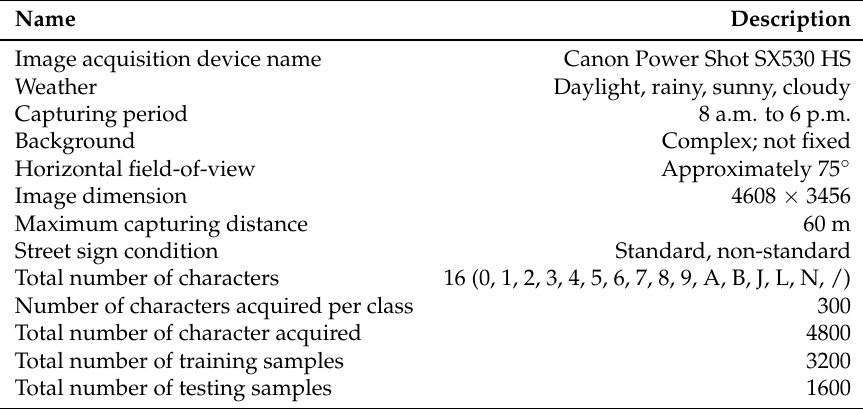
Table 1. Camera specification and image acquisition parameters.